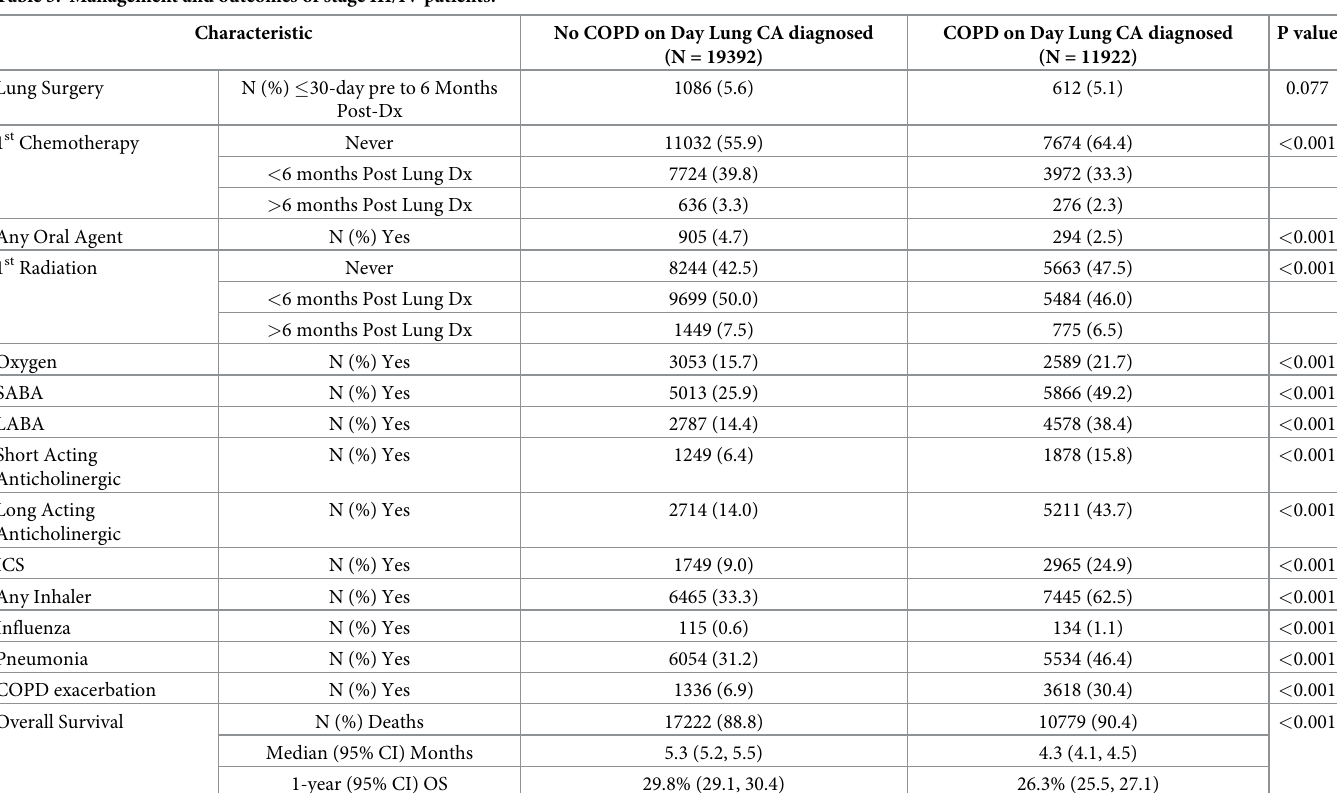
Table 3. Management and outcomes of stage III/IV patients.